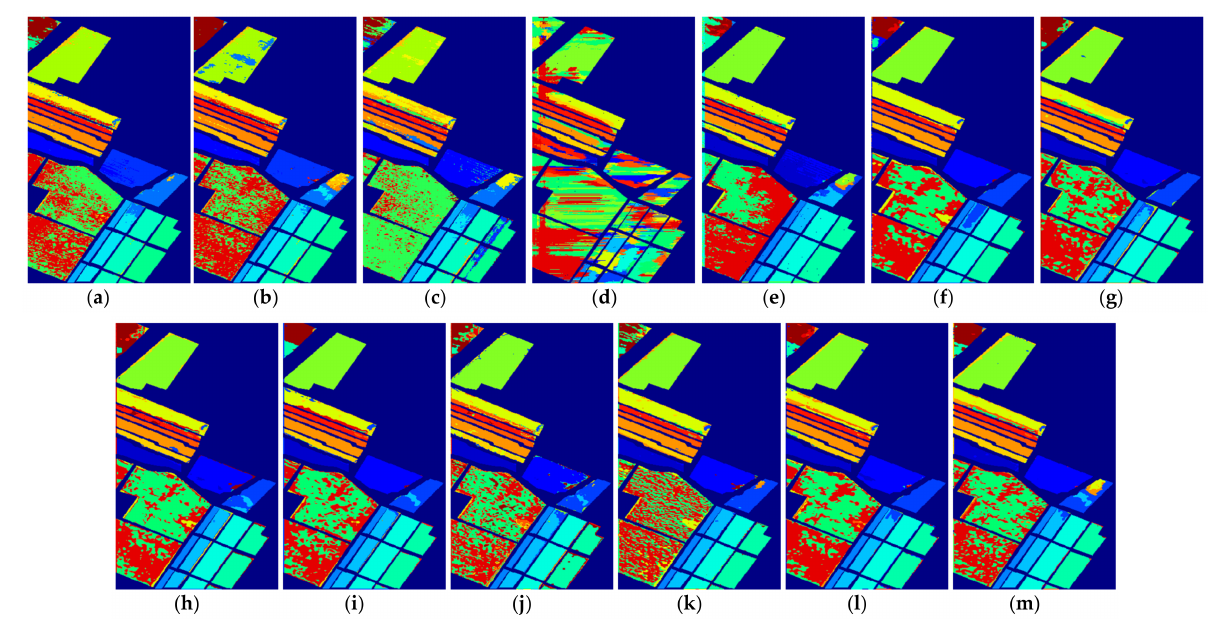
Figure 10. The classification maps of all methods with five samples on Salinas dataset. ( a ) SVM; ( b ) SS-LapSVM; ( c ) 3D-DENSEnet; ( d ) 3D-Gan; ( e ) SS-CNN; ( f ) 3D-CNN; ( g ) 3D-CNN k - means ( h ) 3D-CNN ours ; ( i ) 3D-CNN hardlabel ; ( j ) SSRN; ( k ) SSRN k - means ; ( l ) SSRN ours ; ( m ) SSRN hardlabel .